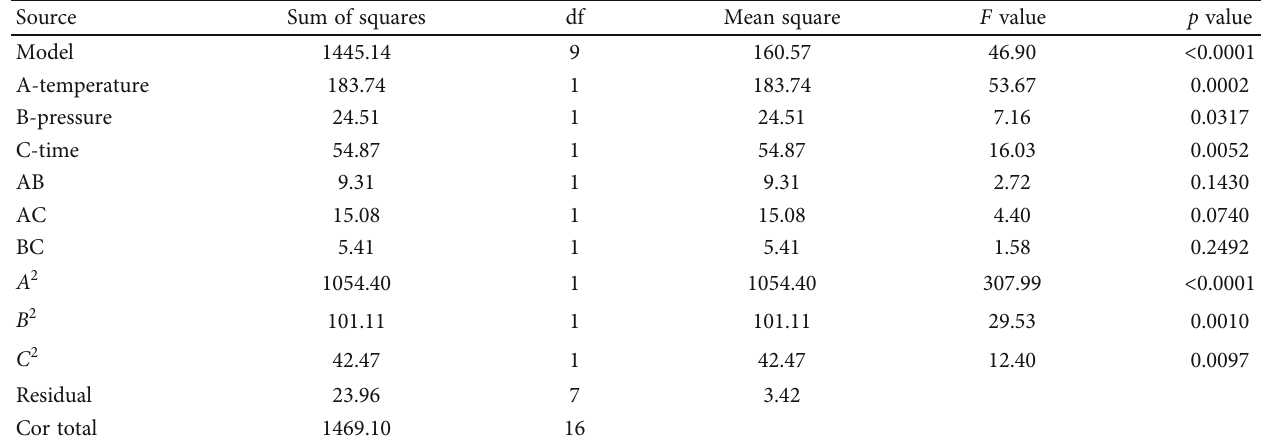
Table 3: ANOVA for fl exural strength.